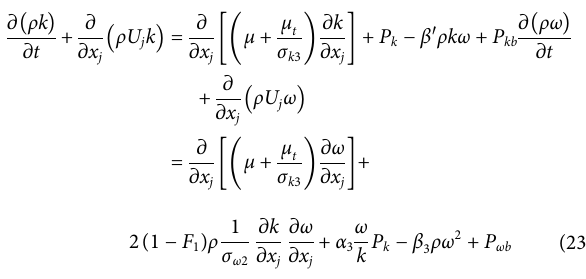
Fluent contains two equation turbulence models such as k − ε and k − ω , among which the k − ε model is a high Reynolds number model, which is mainly used in fully developed turbulent regions far from the wall. The k − ω model is a low Reynolds number model, which is mainly used for wall restricted fl ow and boundary layer problems. For refrigerated and insulated vehicles, in order to accurately analyze the air fl ow conditions inside the compartment, this paper considers the respective advantages of the above models, and selects the shear stress k − ω turbulence model (shear stress transport, SST) for calculation. This model is a combination and improvement of k − ε and k − ω turbulence models, and the k − ω model is used near the wall. layer can more accurately predict the separation of the fl uid from the wall and the low Reynolds number fl ow near the wall. Choose